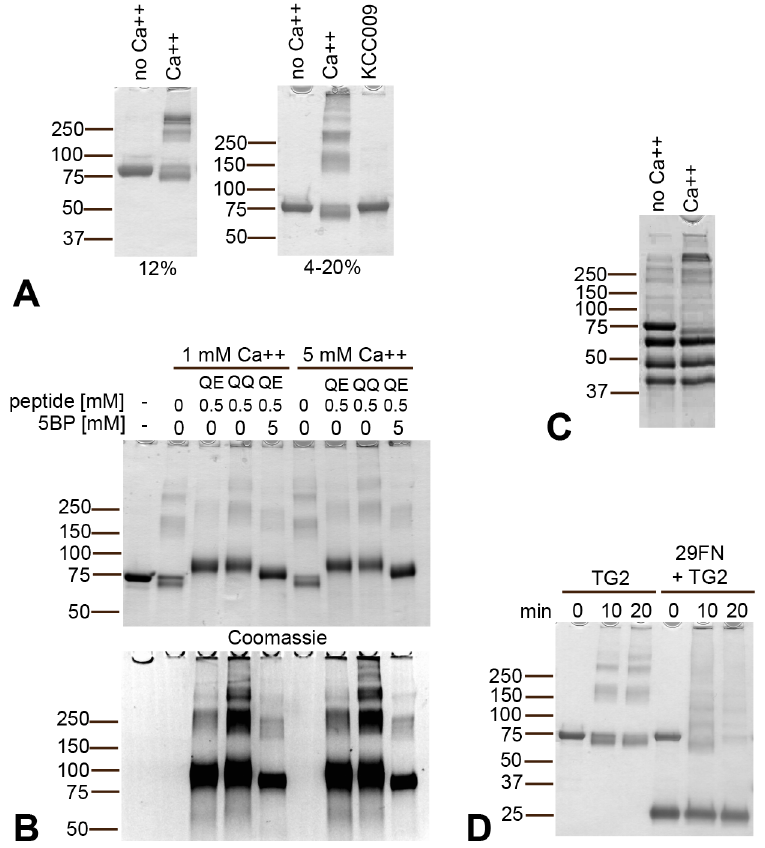
Fig 1. TG2 self-crosslinking in the absence or presence of competitor substrate. (A) TG2 (2 μ M) incubated in the presence of CaCl 2 will cross-link itself into complexes that can be resolved by gradient SDS-PAGE (4 – 20%) but not by standard 12% SDS-PAGE. Self-crosslinking requires TG2 catalytic activity and does not happen in the absence of CaCl 2 or presence of an active site inhibitor. (B) TG2 (1 μ M) self- crosslinking as seen by gradient SDS-PAGE (at 15min) occurs even in the presence of a high excess of glutamine donor substrate (DQ2.5-glia- α 2-QQ-FITC QQ; DQ2.5-glia- α 2-QE-FITC, QE) or primary amine (5BP) (Coomassie). Incorporation of the FITC-labeled peptides is observed both in TG2 monomer and TG2 multimers (FITC). (C) Incubation of TG2 (78 kDa) together with human albumin (64 kDa), human IgG (50 kDa + 25 kDa) and ovalbumin (45 kDa) in the presence of CaCl 2 results in selective disappearance of the monomeric TG2 band, indicating that self-crosslinking is a specific event. (D) Incubation of TG2 with excess of the known protein substrate 29kDa FN fragment (29FN) results in disappearance of TG2 monomer and incorporation of both TG2 and 29FN into complexes.